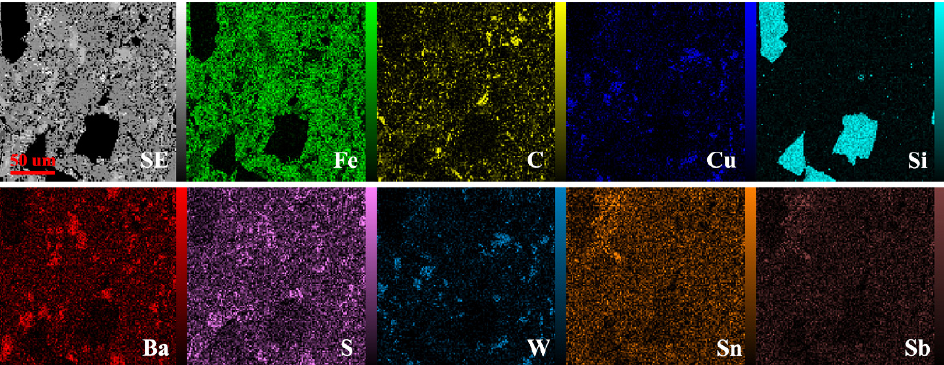
Figure 5. SEM micrograph and elemental map analysis of sample 6.